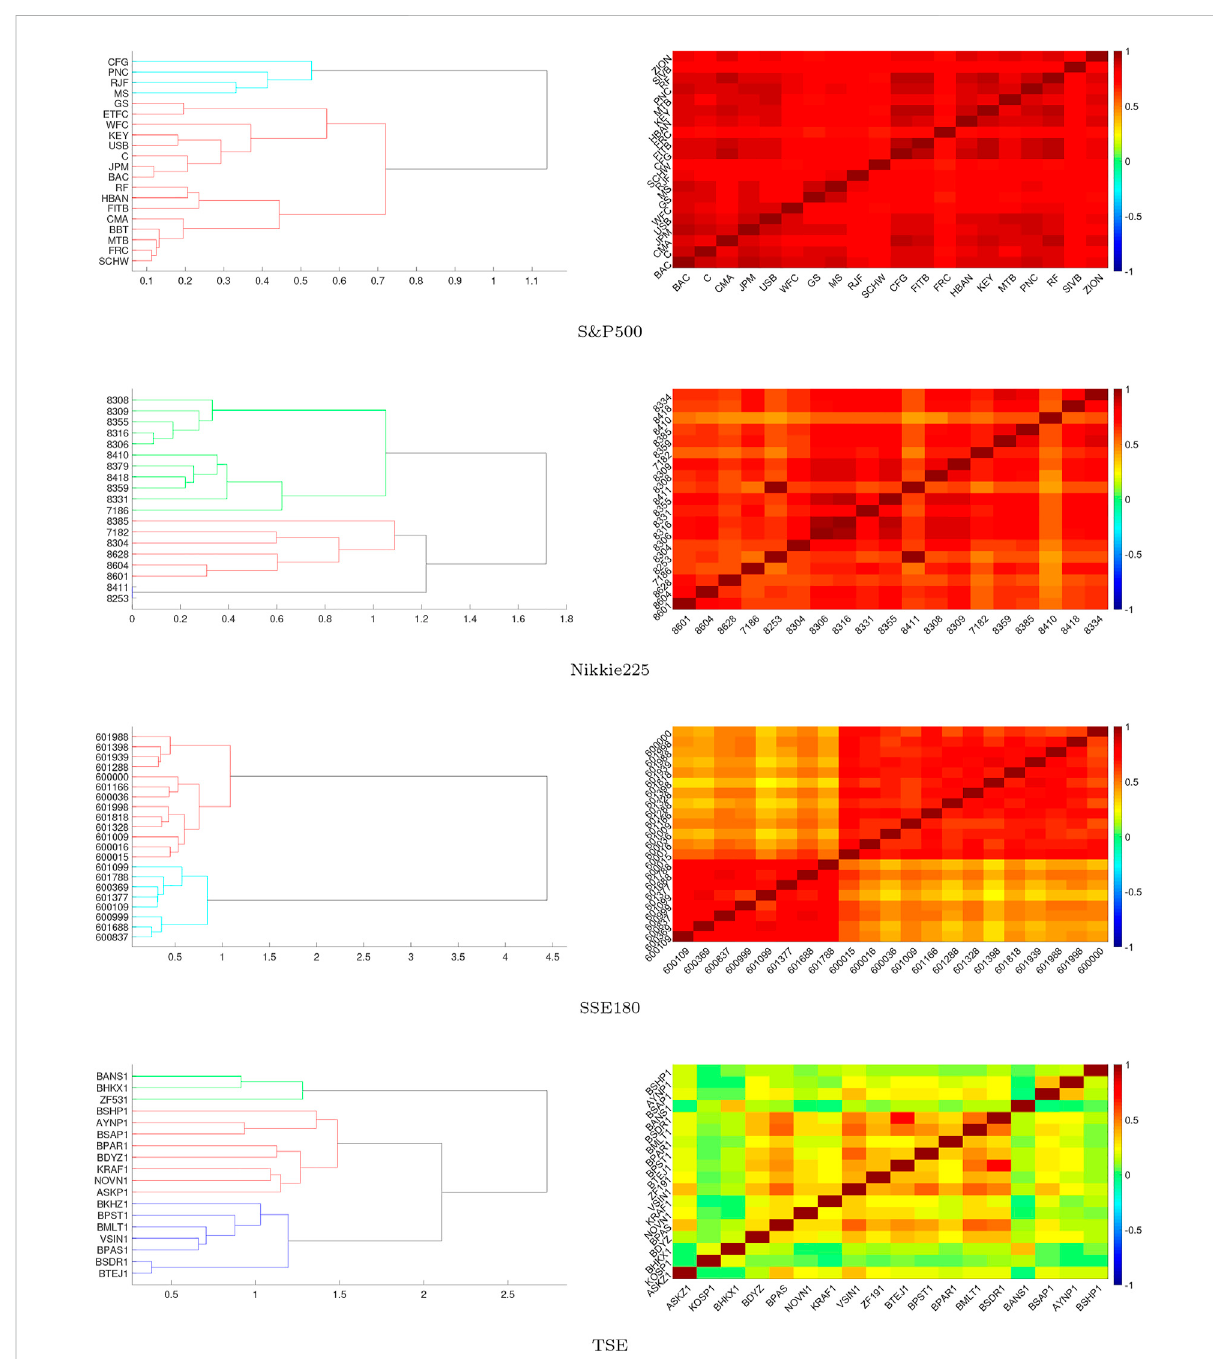
FIGURE 2 Comparing the dendrograms and Heat maps of indices: vertical axis in dendrograms represents proximity of components. In mature markets, thiscriteriashowsastrongcorrelationandinTSE,itshowsaweakcorrelationbutinSSE180,themarketisseparatedinto2sections.Eachsectionhas a strong correlation but another section is weak. In heat maps warmer colors show a stronger correlation with markets and the results are similar to